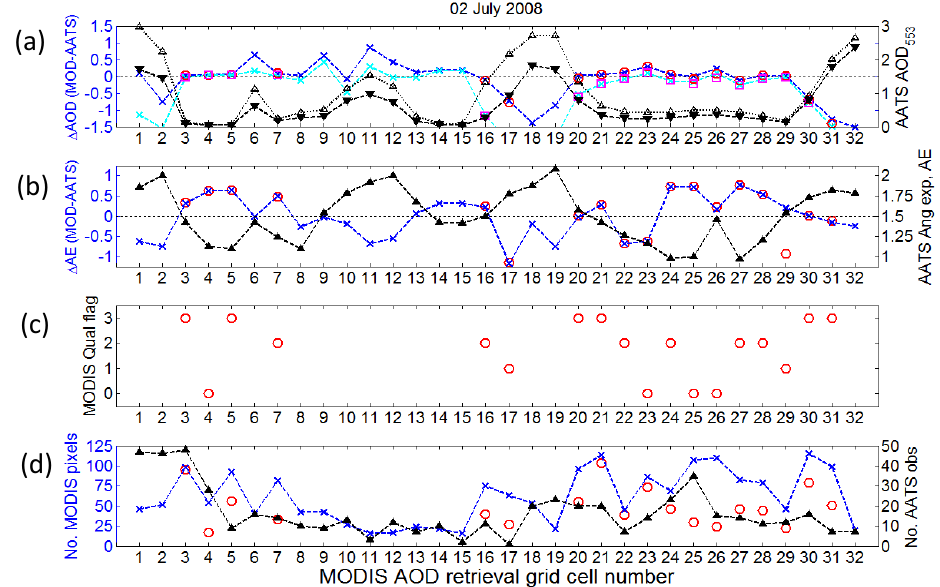
Fig. 6. For 2 July: parameters pertaining to the comparison of MODIS 10km retrievals and AATS AOD as a function of the 10km retrieval grid cell numbers shown in Fig. 5. (a) AATS AOD (right axis scale) before (black solid triangles and dashed line) and after (black open triangles and dotted line) addition of the below aircraft AOD estimates, corresponding MODIS minus AATS AOD differences (left axis scale) for the MODIS operational retrievals (red circles – unadjusted AATS AOD; magenta squares – adjusted AATS AOD) and for the special MODIS retrievals (blue crosses and dashed line – unadjusted AATS AOD; cyan crosses and dashed line – adjusted AATS AOD) with the aerosol cloud mask off. (b) Calculated AE values for unadjusted AATS (black, right axis scale), and MODIS minus AATS AE differences (red – MODIS operational; blue – MODIS aerosol cloud mask off, left axis scale). (c) MODIS quality flags for the operational retrievals. (d) Number of 0.5km resolution pixels (left axis scale) used in the MODIS 10km retrieval (red for operational retrieval, blue for retrievals with aerosol cloud mask off), and number of AATS AOD measurements (black, right axis scale) within each 10km grid cell.